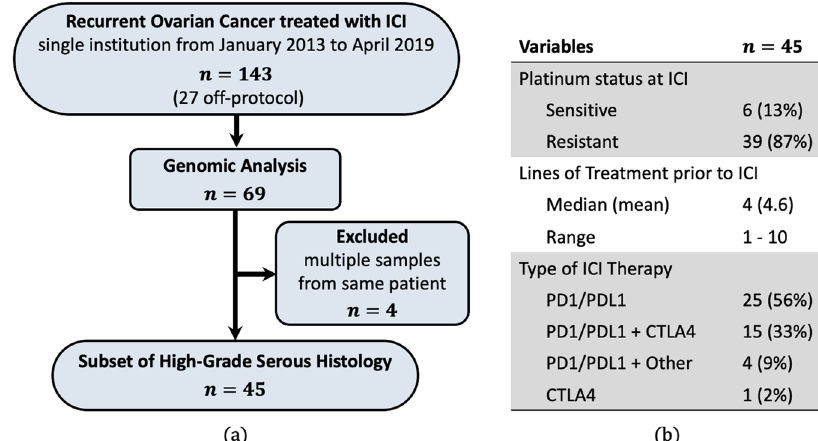
Fig. 4 Patient selection and clinical characteristics. a Patient selection. b Clinical characteristics of patients with recurrent HGSOC administered ICI